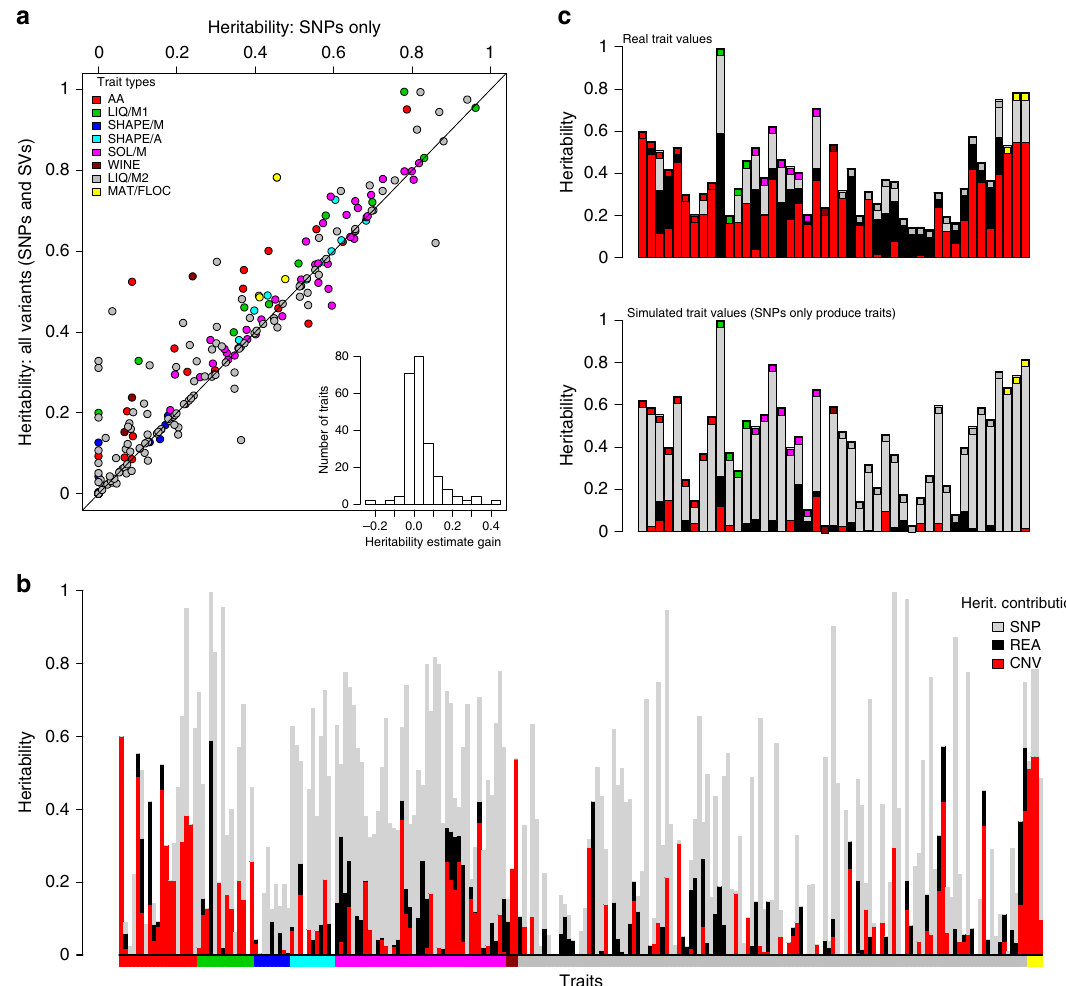
(Supplementary Table 5), using only SNP data ( x axis) range from 0 to 96% (median 29%). Adding SVcalls ( y axis) increases the estimates (median 34%), with estimates for some traits being improved up to a gain of 43% (histogram inset). The diagonal line shows where estimates after adding SVs are the same as those without ( x ¼ y ). Inset: the distribution of the ‘gain’ in heritability after adding SVcalls (median 0.4%, maximum 43%). Points are coloured by trait types, according to legend top left. ( b ) The contributions of SNPs (grey), CNVs (red) and rearrangements (black) to heritability varied considerably between traits. Coloured bars along the x axis indicate the trait types. heritability estimates are in Supplementary Table 5. The panel below bars indicates trait types as in the legend for part ( a ). ( c , top) For some traits, SVs explained more of the trait variation than SNPs. Boxes are coloured as legend in a . ( c , lower) Analysis of simulated data generated with assumption that only SNPs cause traits indicates that the contribution of SVs to trait variance is unlikely to be due to linkage. Traits from left are; with red inset at top, free amino acid concentrations (glutamine, histidine, lysine, methionine, phenylalanine, proline and tyrosine), with green inset liquid media growth traits (maximum mass in minimal media, time to maximum slope, most rapid slope and highest cell density in rich media), in with magenta inset colony growth on solid media (with Brefeldin, CuSO 4 , H 2 O 2 , hydroxyurea, 0.0025% MMS, 0.005% MMS, with proline and 0.001% SDS), wine traits with Burgundy inset (malic acid accumulation and glucose þ fructose ultilisation), with grey inset liquid media conditions (caffeine lag, rate and efficiency, CsCl1 2 efficiency, diamide growth rate, EMS growth rate, ethanol efficiency, ethanol growth rate, galactose growth rate, growth rate at 40 (cid:2) C, HqCl 2 lag, KCl efficiency, MgCl 2 efficiency, MMS lag, NiCl lag, unstressed lag and rate, SrCl efficiency, tunicamycin lag and rate), and with yellow insets mating traits (the proportion of free spores, mating figures observed and total spore